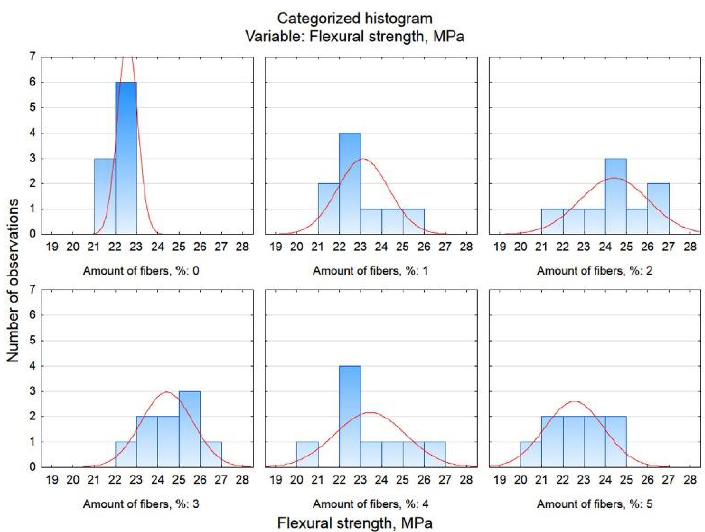
Figure 8. Categorized histograms of flexural strength related to fibre content.